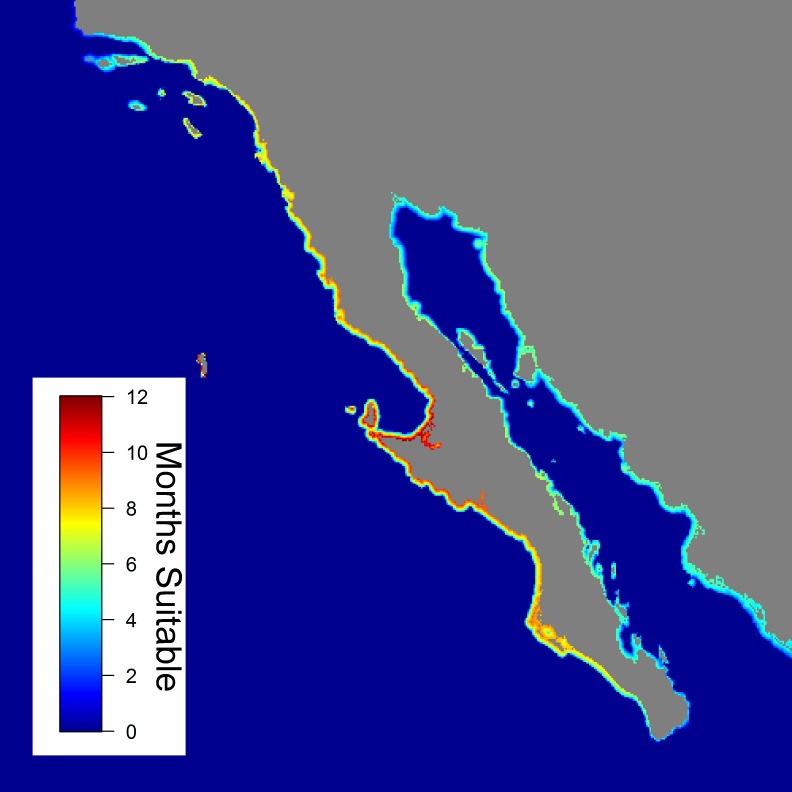
Map of habitat suitability in the Northeast Pacific Ocean.Map of the Northeast Pacific Ocean, with colors representing the monthly overlap in the 25% core area.